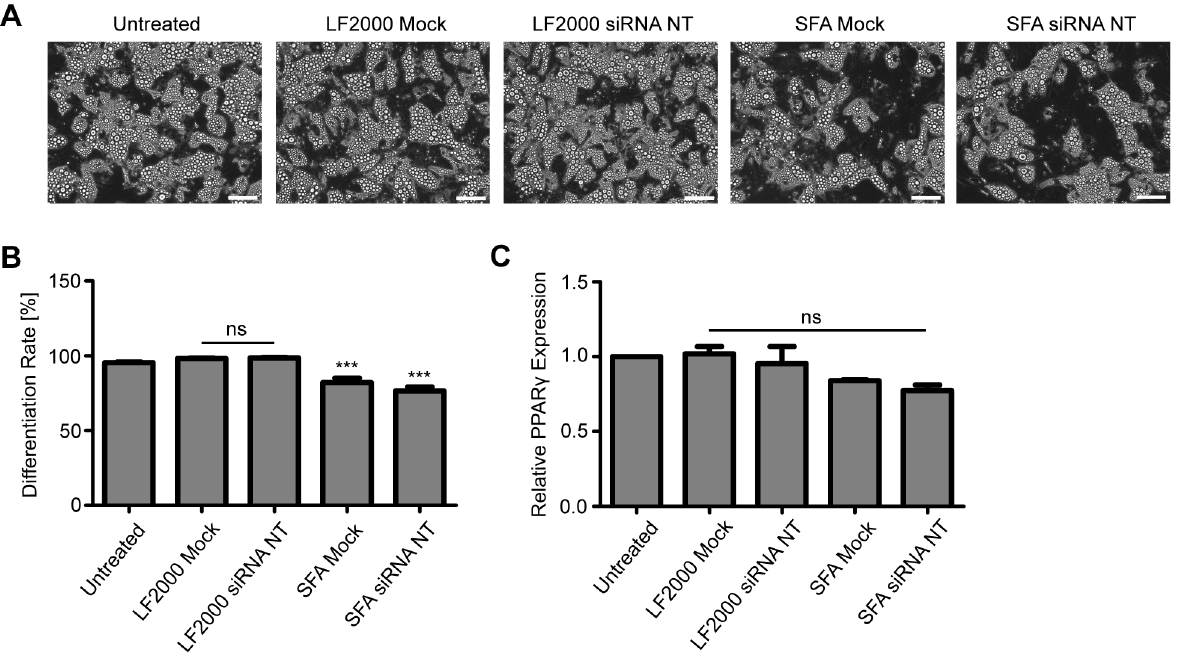
Figure 5. Transfected SGBS preadipocytes retain their ability for adipogenic differentiation. Untreated cells, cells treated with transfection agent alone (mock) and cells transfected with a nontargeting (NT) control siRNA were exposed to differentiation medium 48 h after transfection and analyzed on day 14 of adipogenic differentiation. Phase contrast micrographs (A) taken with a 20x objective. Scale bars are 100 m m. Pictures from one representative experiment out of two performed are shown. Differentiation rates (B) and the qPCR analysis of the expression level of an adipocyte marker gene PPAR c (C). The experiment was carried out three times independently and the results are expressed as mean and SEM. ***p , 0.0001 untreated vs.